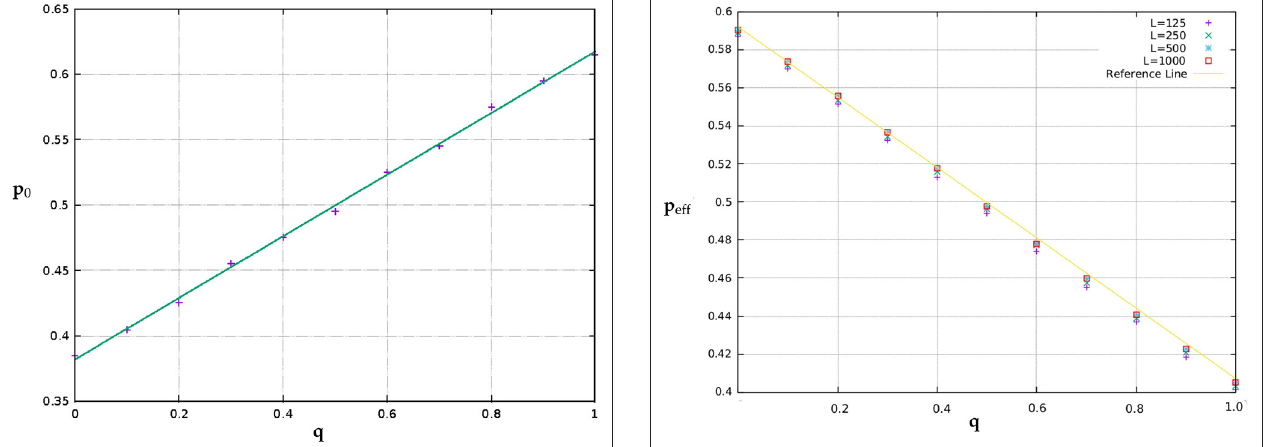
FIGURE 4 | Percolation thresholds for different values of diagonal connection probabilities q and system sizes L . The error bound for the data points is ±